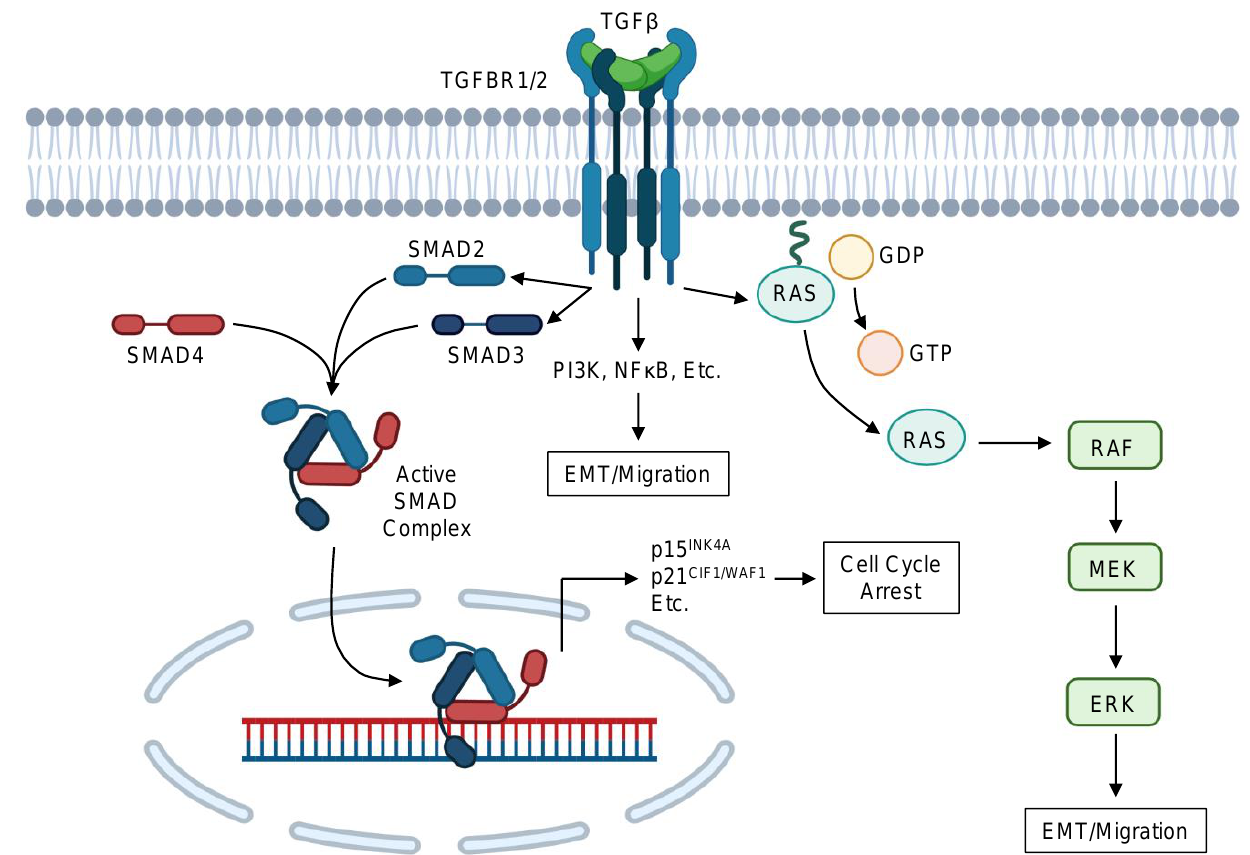
Figure 1. Simplified schema of TGF β signaling in PDAC cells. TGF β family ligands associate with the N-terminal extra- cellular ligand-binding ectodomain of the type 2 TGF β receptor (TGFBR2), which then recruits the type 1 TGF β receptor (TGFBR1). TGFBR1 phosphorylates SMAD2 and SMAD3 proteins via its serine/threonine kinase domains, leading to the